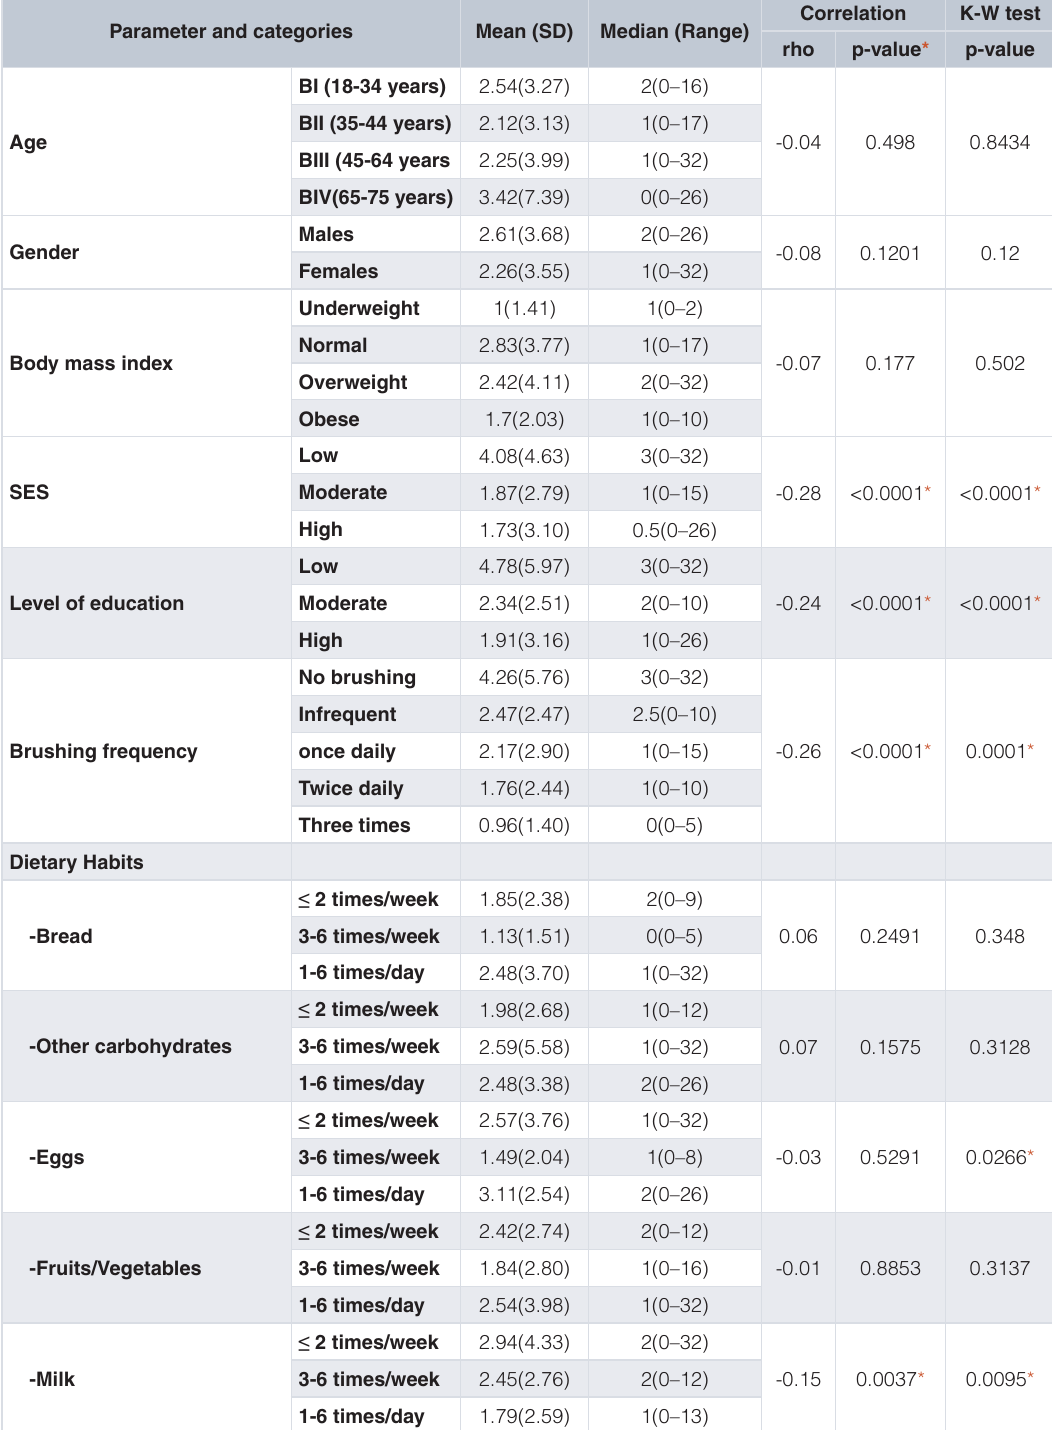
Table 3. Decayed teeth and different risk factors (N=